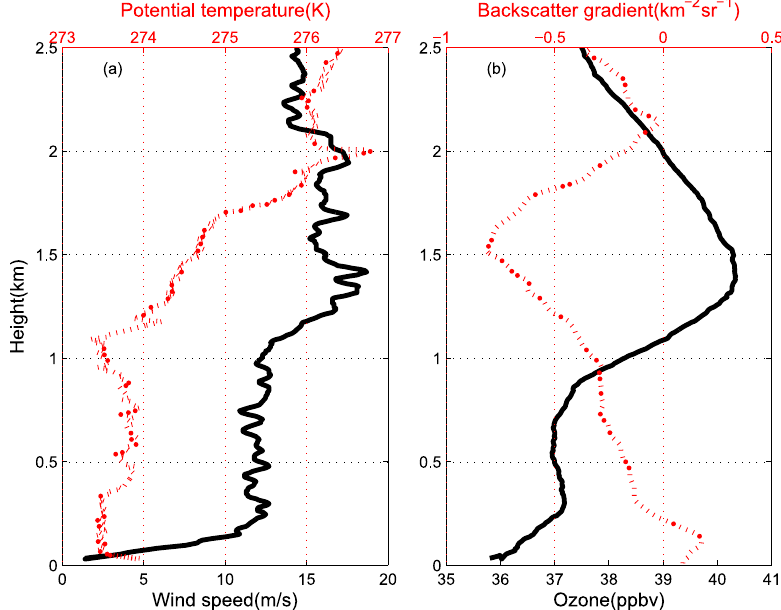
Figure 5. Virtual potential temperature and wind speed (a) , and ozone and backscatter gradients (b) at 14:00LT on 29 December 2009 in